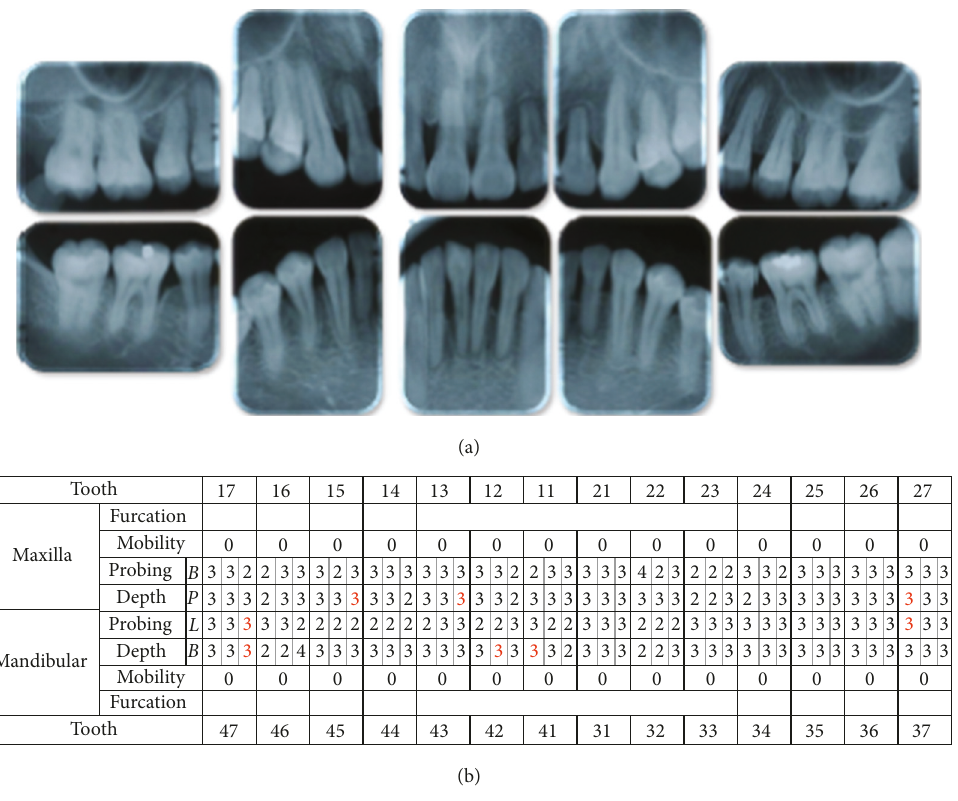
Figure 11: Post-retention dental radiographs (a) and periodontal examinations (b) are shown. The red color indicates bleeding on